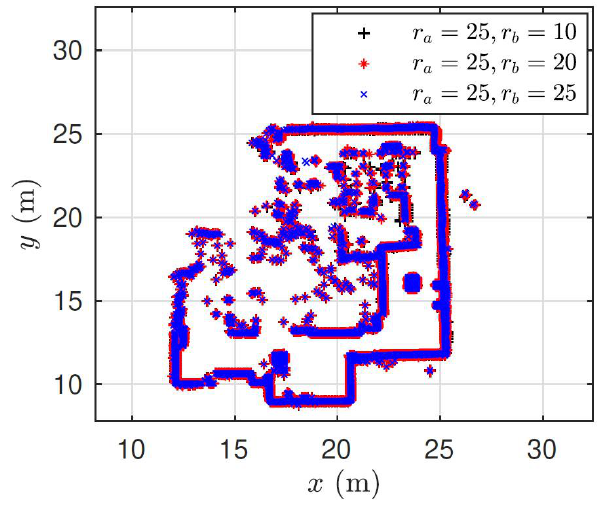
Figure 12. Occupied pixel locations of three global maps as a result of map fusion. Each map is obtained as a merging result between a fixed map a m of resolution r a = 25 cell/m and a moving map b m of resolutions r b = 10, 20, 25 cells/m. Table 1. Mean and deviation of performance parameters while merging maps of same and different grid resolutions.